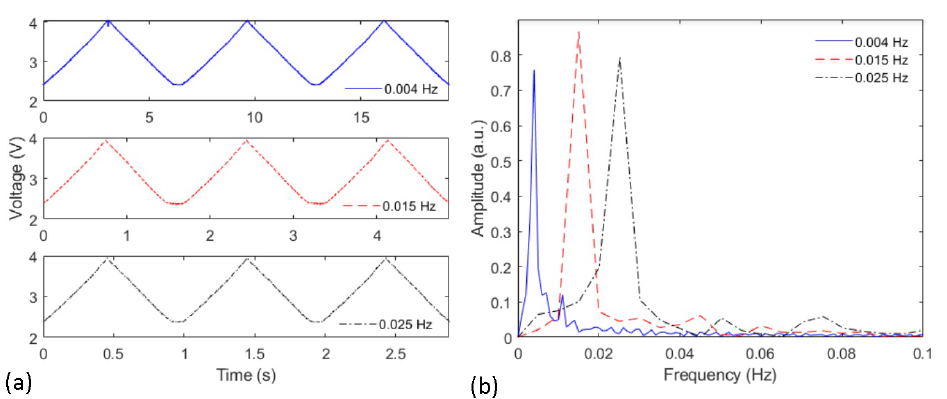
Figure 5. ( a ) Voltage variation as a function of the time for the sensor at each frequency. ( b ) FFT of the sensor response at each angular velocity